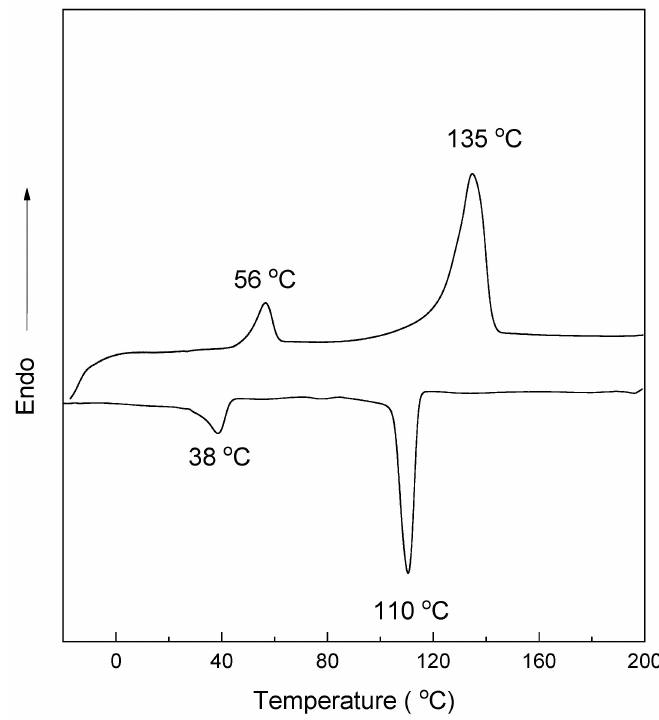
Figure 3. DSC curves of PCL -b- PE -b- PCL. Up: heating scan; down: cooling